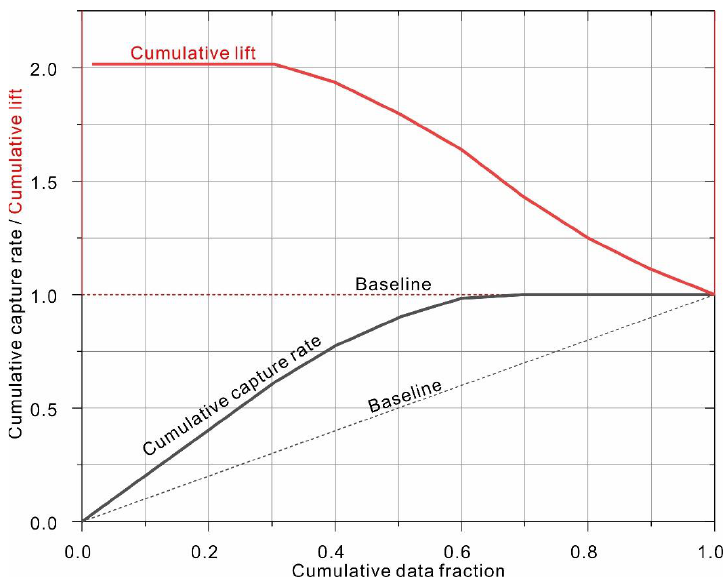
Figure 8. Cumulative gain and lift charts for the top-performing model (H2O 1 ) based on testing